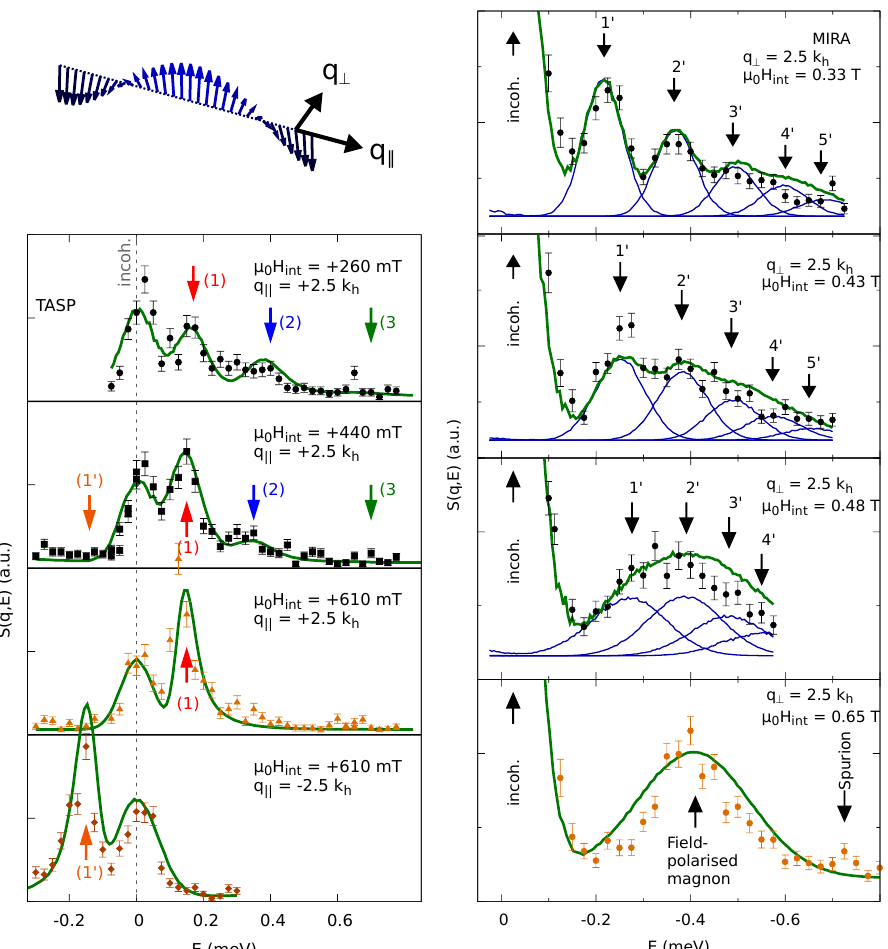
Figure 3. The figure (reproduced from [30], c (cid:13) by the American Physical Society, USA) shows the field-dependent evolution of the helimagnon excitations for the reduced momentum transfer q parallel ( left ) and q perpendicular ( right ) to the helix in units of the spiral